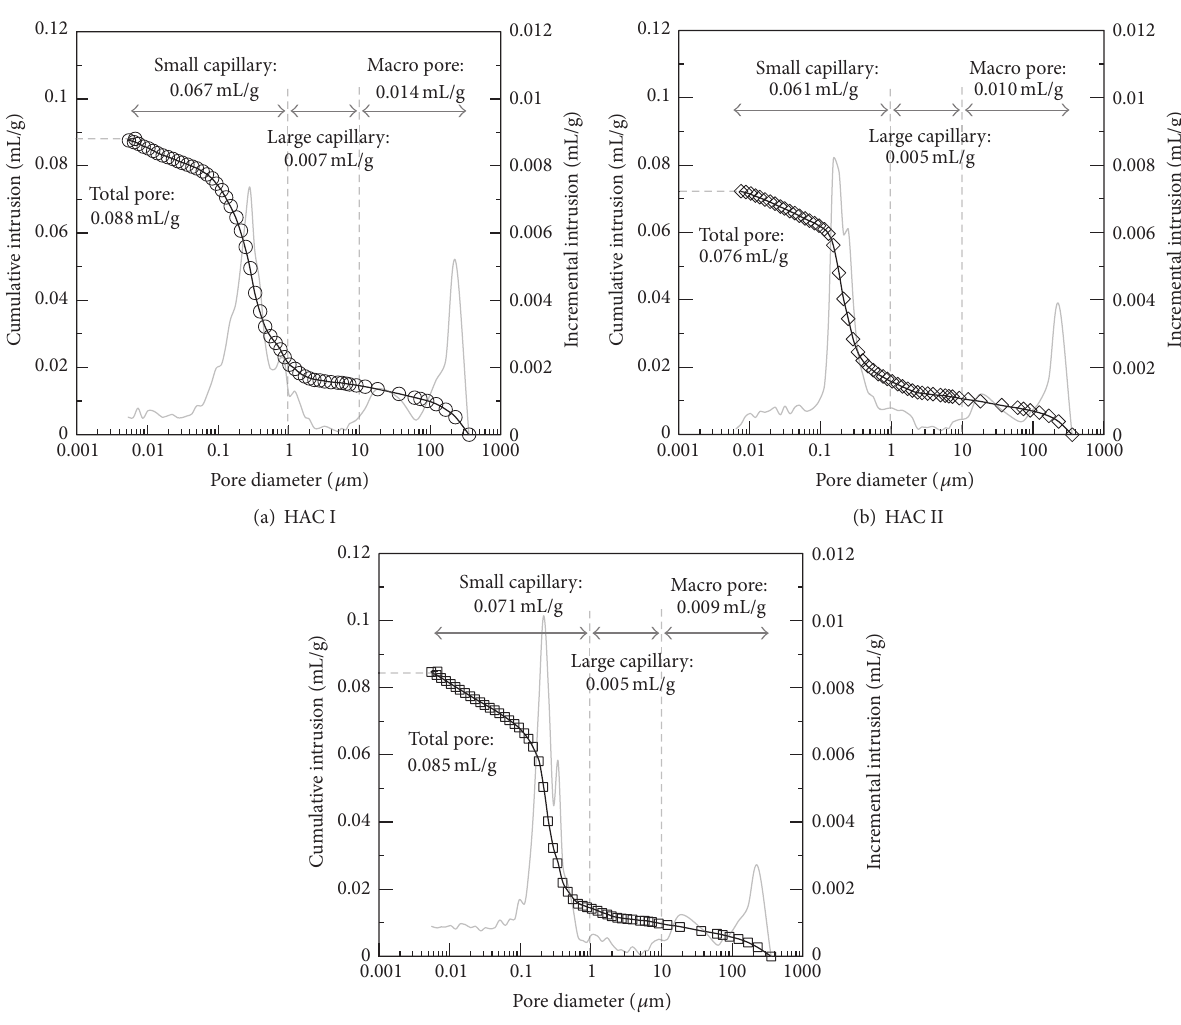
Figure 6: Pore size distribution of mortar to a given pore diameter with different HAC